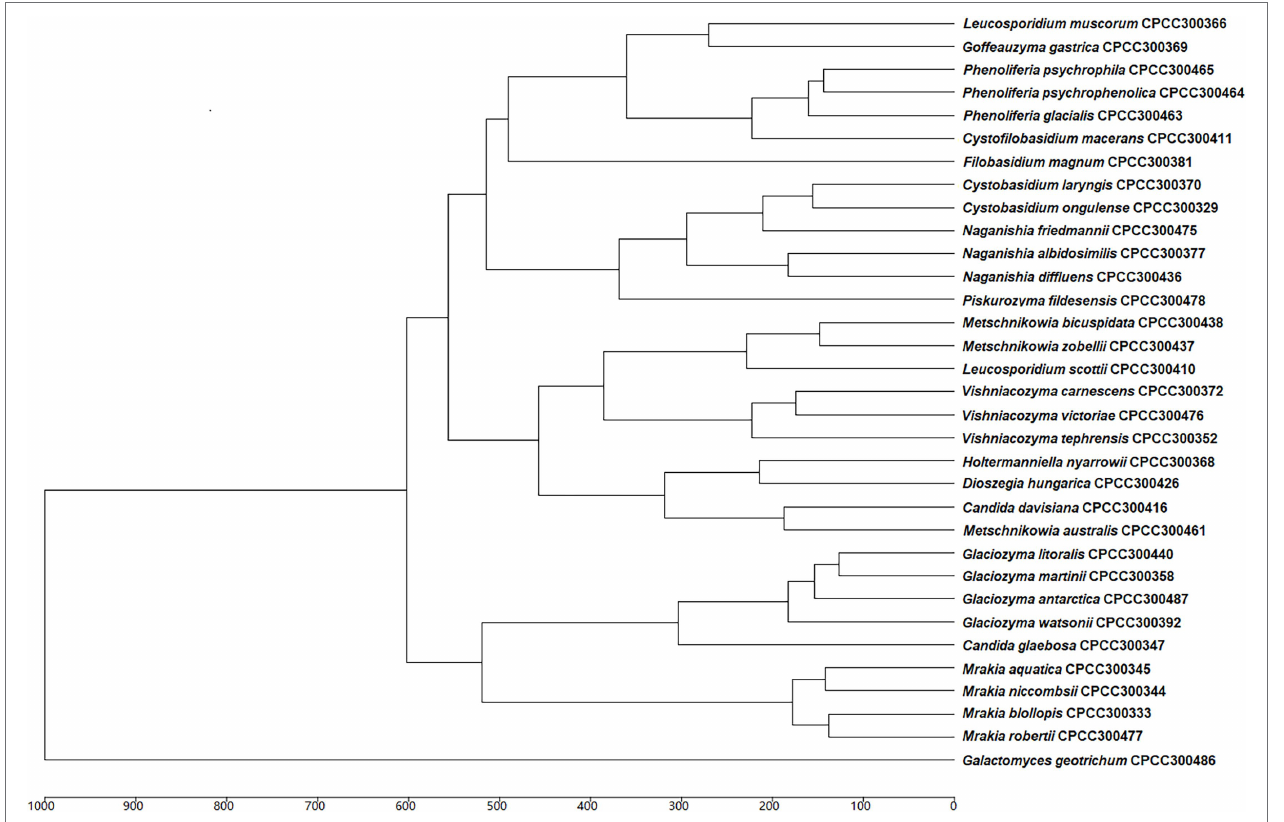
FIGURE 2 | Main spectra profile-based dendrogram of the 33 yeast species included in the supplementary